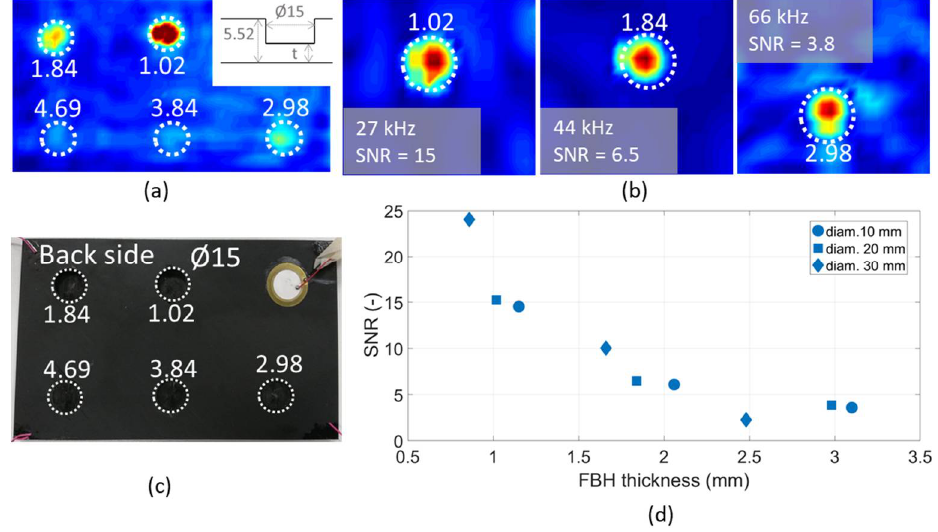
Figure 1. LDR for FBHs. ( a ) FBD over entire excitation bandwidth ( b ) ODS at LDR and ( c ) picture for the coupon with FBHs of diameter 15 mm; ( d ) SNR for all FBH S showing LDR